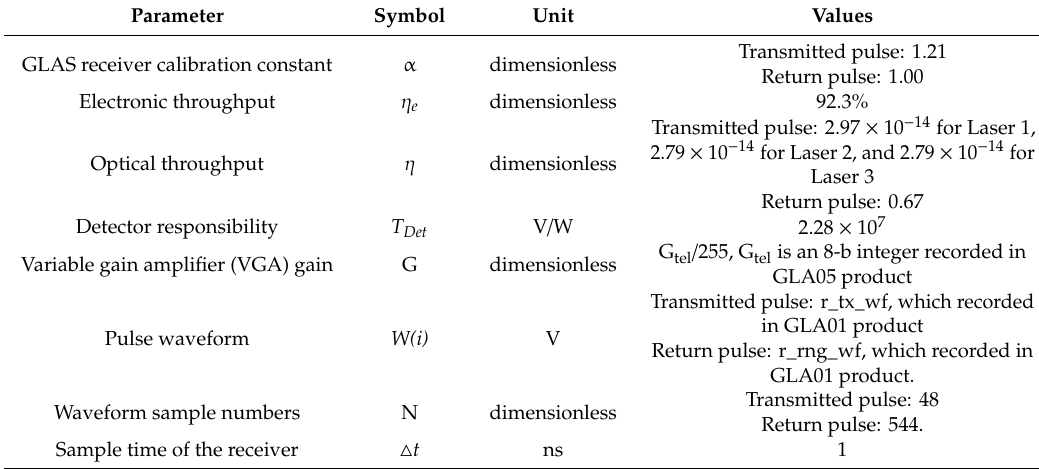
Table A1. GLAS receiver corresponding equipment parameters for calculating transmitted and return pulse